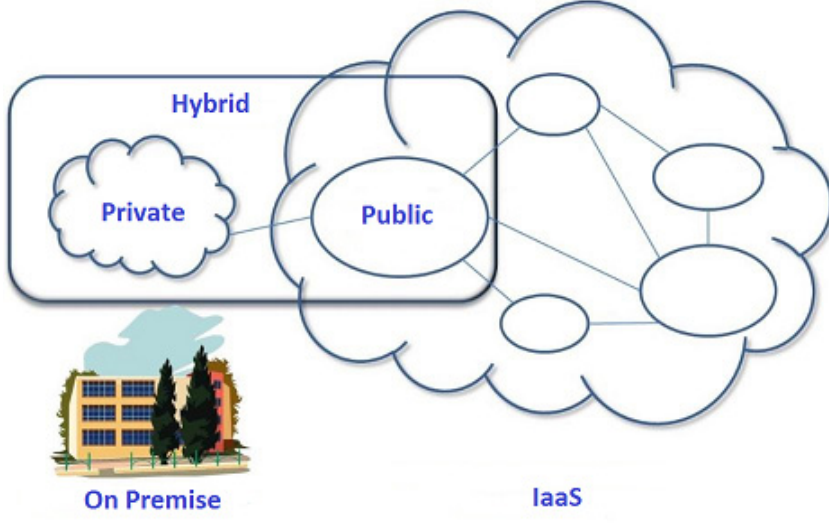
Figure 3. Basic cloud architecture models.